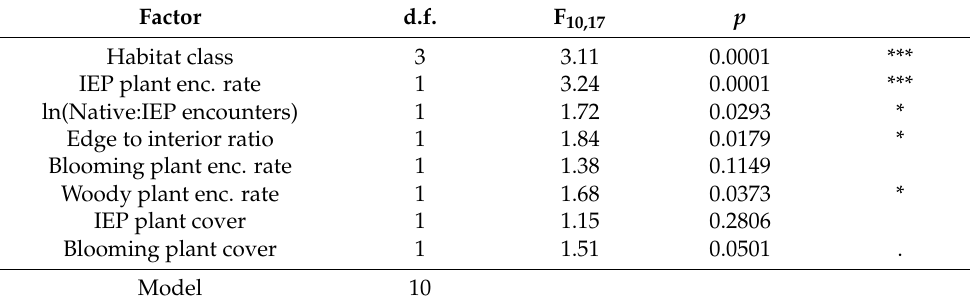
Table 6. PerMANCOVA results examining the effects of habitat type, IEP plant encounter rate, ln(Native:IEP encounters), edge to interior ratio, blooming plant encounter rate, woody plant en- counter rate, plant diversity, IEP plant cover, and blooming plant encounter rate on combined plant and Lepidoptera community composition. More complex models with additional terms and interac- tions between terms were considered prior to model pruning. Environmental factors not included here can be interpreted as being insignificant. Legend: ., 0.05 ≤ p < 0.1; *, 0.01 ≤ p < 0.05; ***, p <